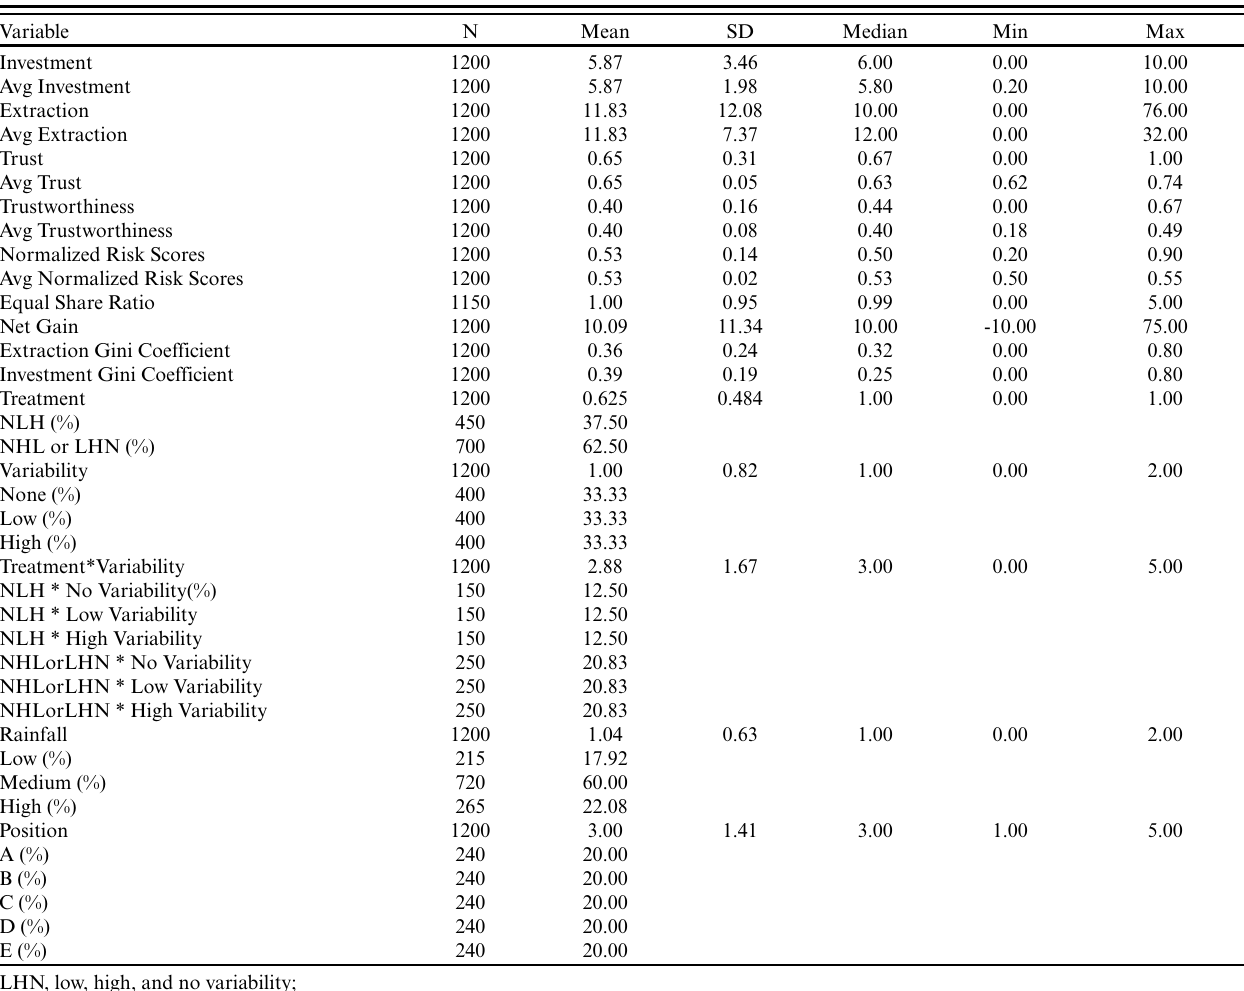
Table 3 . Definition and summary statistics for the variables used in the statistical model. Variables are defined in the main text. For categorical variables, the percentage of values in a specific category is reported in the mean column jointly with the general mean value. Avg refers to group averages per round. Gini coefficients were calculated over a specific group and varied at each